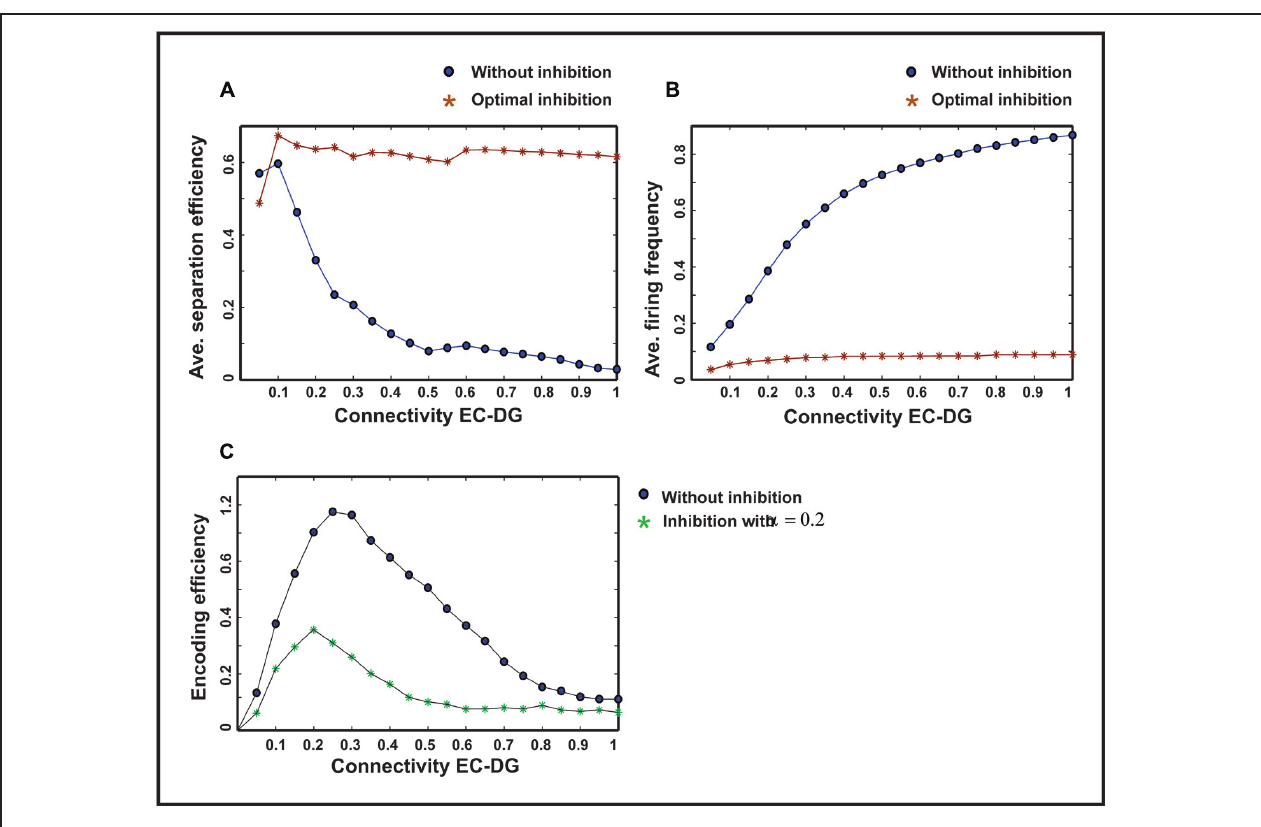
(B) Average firing frequency over different firing probability of EC. In the presence of optimal inhibition parameter value very low firing frequency is obtained for all connectivity rates between the EC and the DG. (C) Average single neurons encoding efficiency over different firing probability of EC. In the presence of optimal inhibition parameter value, low MI as the measure of encoding efficiency is obtained, comparing to the absence of inhibition for different connectivity rates between the EC and the